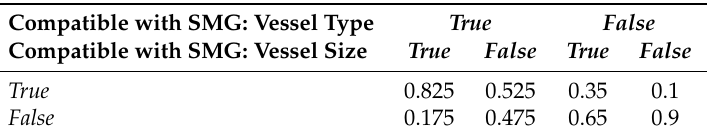
Table 5. Conditional probability table of the query variable Compatible with smuggling of goods : vessel characteristics for the Ionian Sea